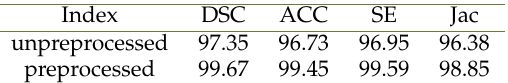
Fig. 5. Image comparison before and after preprocessing Table 2. Comparison of segmentation results between preprocessed and